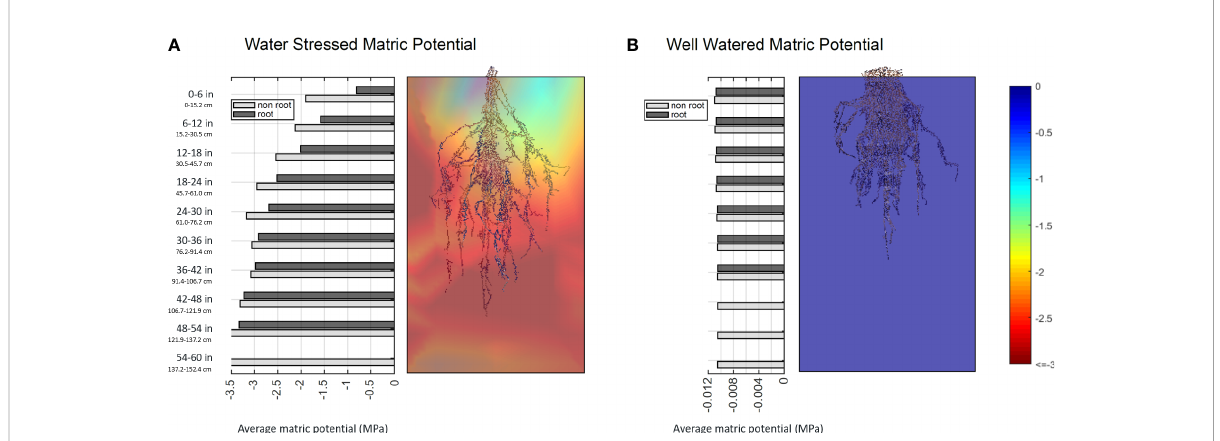
FIGURE 13 Bar plots of average matric potential for root cuboids and non-root cuboids at every layer for a water stressed sample (A) and a well-watered sample (B) . Values near zero (blue) represent high water availability, while more negative values (red) denote a lower matric potential of the growth media and lower water